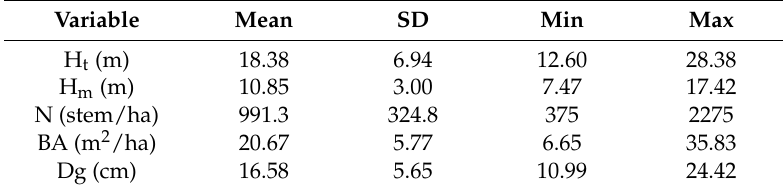
Table 1. Summary statistics for all selected permanent sample plots (PSPs) ( n =